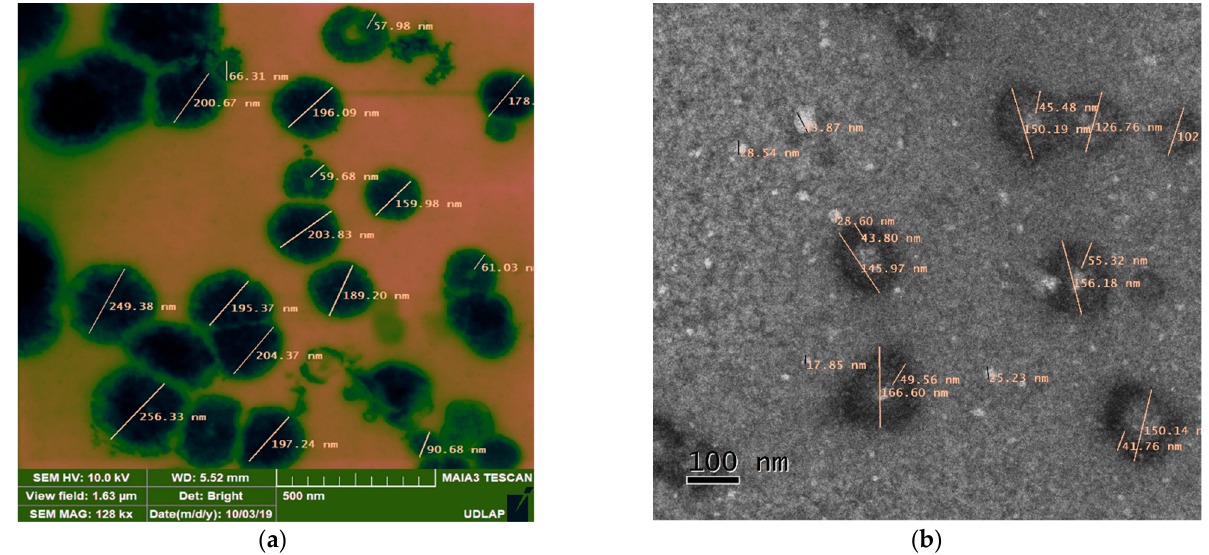
Figure 3. ( a ) STEM and ( b ) TEM images of the developed CasIII-ia niosomal formulation.